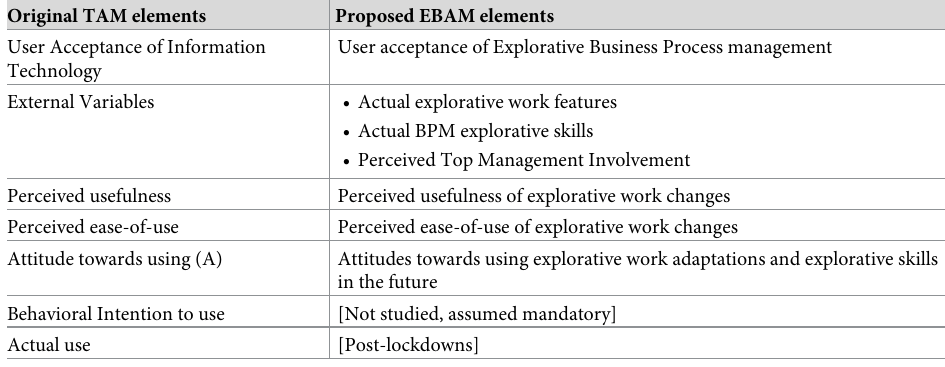
Table 2. Linking TAM to